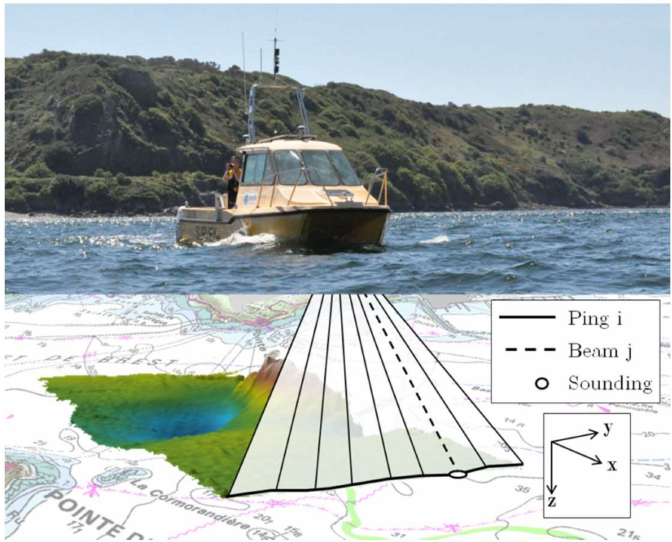
Figure 2. Multibeam echosounder acquisition geometry. Soundings can be described in either swath or geographic modes. In hydrography, the z -axis convention is positive